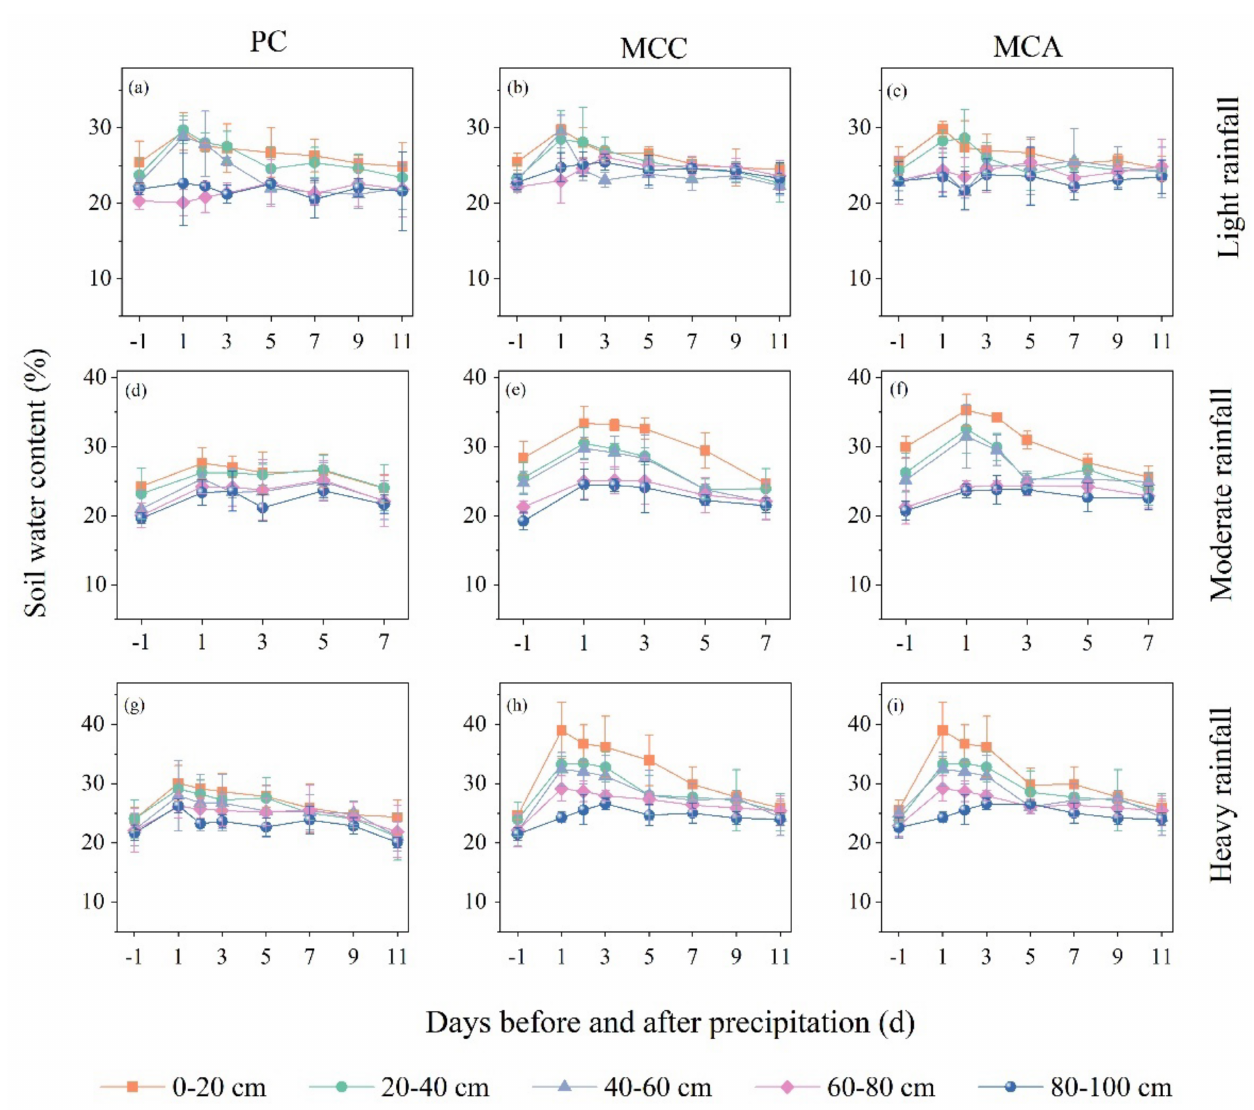
Figure 2. Daily soil water content (SWC) of each soil profile in PC ( a , d , g ), MCC ( b , e , h ), and MCA ( c , f , i ). PC: pure C. lanceolata plantation; MCC: mixed plantation with C. lanceolata and C. camphora and MCA: mixed plantation with C. lanceolata and A. cremastogyne